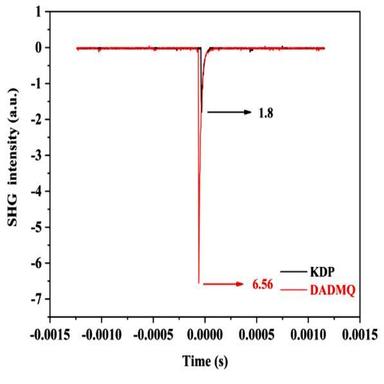
Kurtz powder SHG signal.